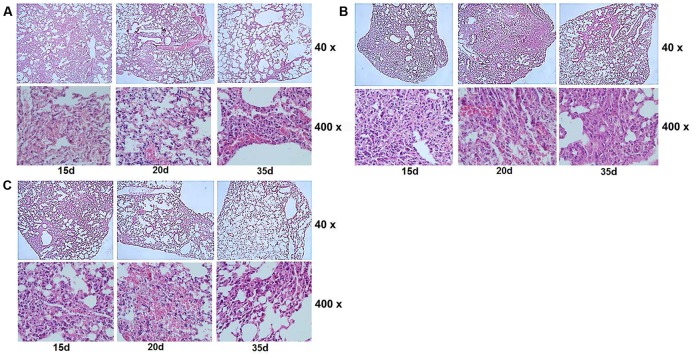
Pathological changes in the lung tissues of each group at different time points (15, 20, and 35 d) post-infection. Images (A–C) indicate the lung tissues of mice infected with MSP, MSW, and MSM, respectively. The structure of pulmonary alveolus of the mice infected by MSW was permeated with inflammatory exudates and infiltrated by inflammatory cells. The alveolar wall indicated congestion and incrassation, with apparent granuloma formation in the lungs at 15 and 20 days post-infection. The data are representative of two independent experiments, n = 6.